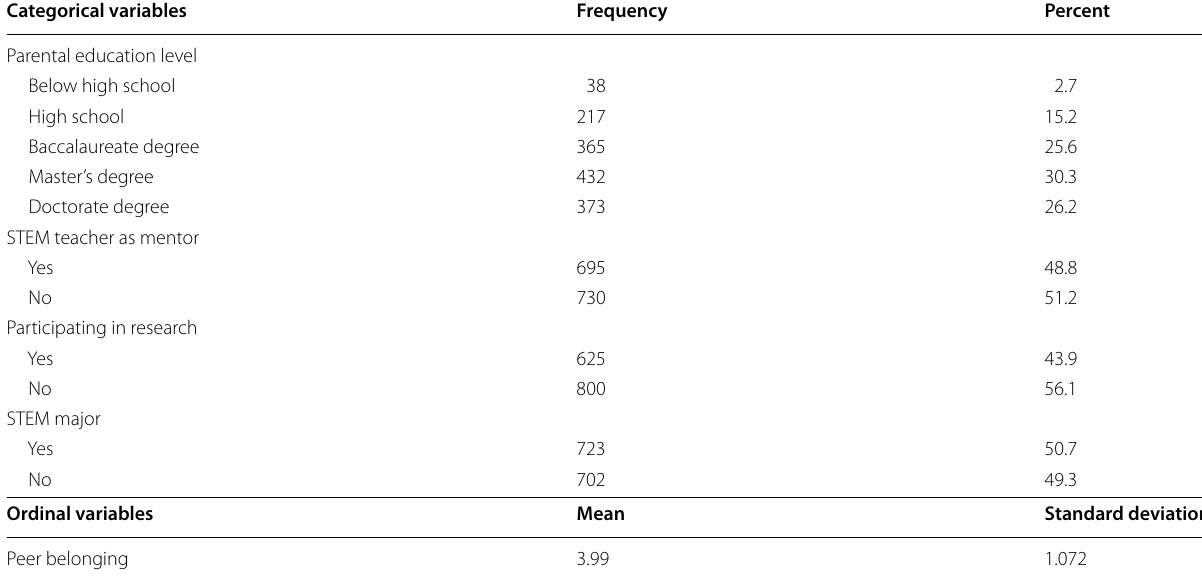
Table 1 Descriptive statistics for measured variables in analysis 1